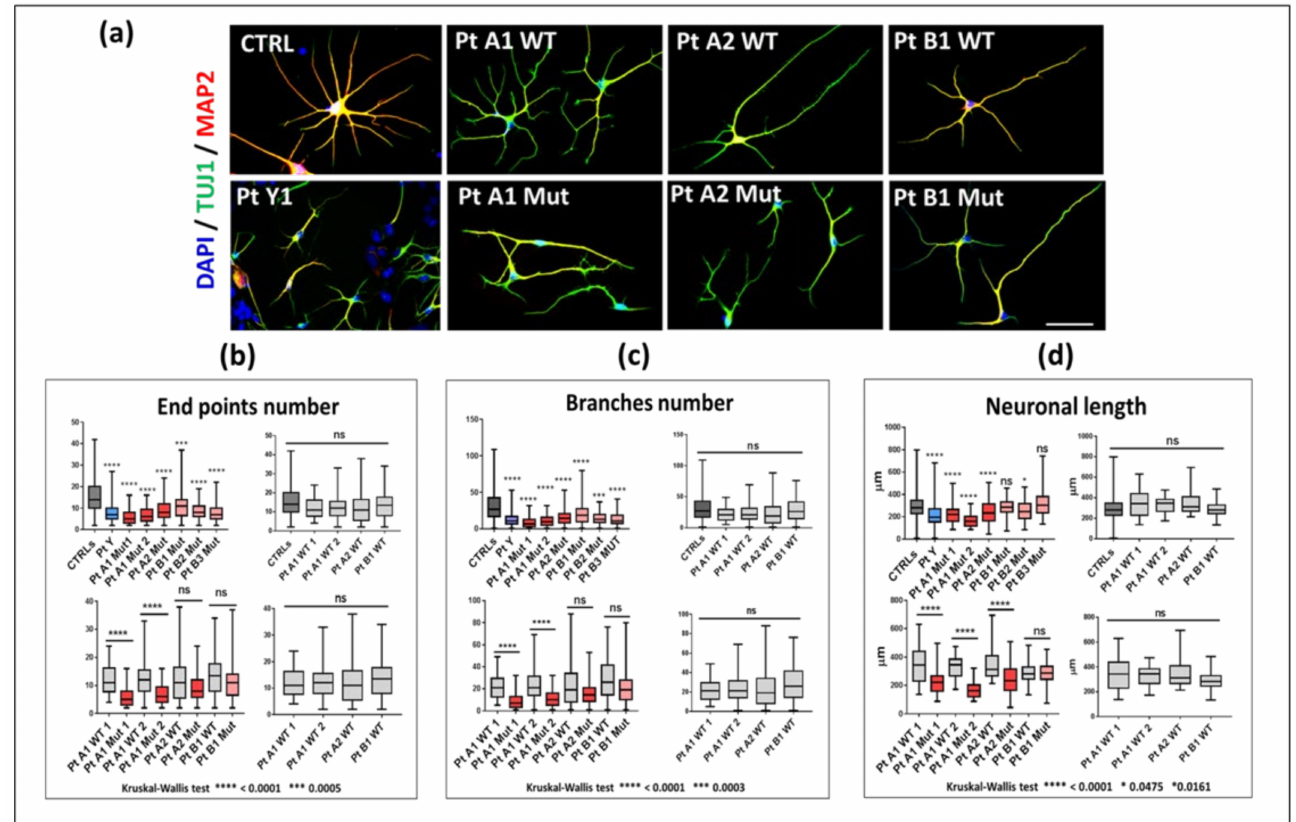
Figure 5. Morphological analysis of young RTT neurons. ( a ) IF of MAP2 (red), TUJ1 (green), and DAPI (blue). Scale bar: 50 µ m. ( b – d ) Box-plots from the comparison between mutant (red) versus isogenic WT clones (light grey) of RTT females and between the male (blue) versus controls (dark grey) for end points number, branches number and neuronal length. Decreased number of end points ( b ), branches ( c ), and neuronal length ( d ) were highly significant in the Kruskal–Wallis test, while no significance was proved in the comparison among wild-type clones. Data were compared using Kruskal-Wallis test. In ( b ) **** p -value < 0.0001, *** p -value = 0.0005; in ( c ) **** p -value < 0.0001, *** p -value = 0.0003; in ( d ) **** p -value < 0.0001, * p -value = 0.0475 and 0.0161. ns: not significant.